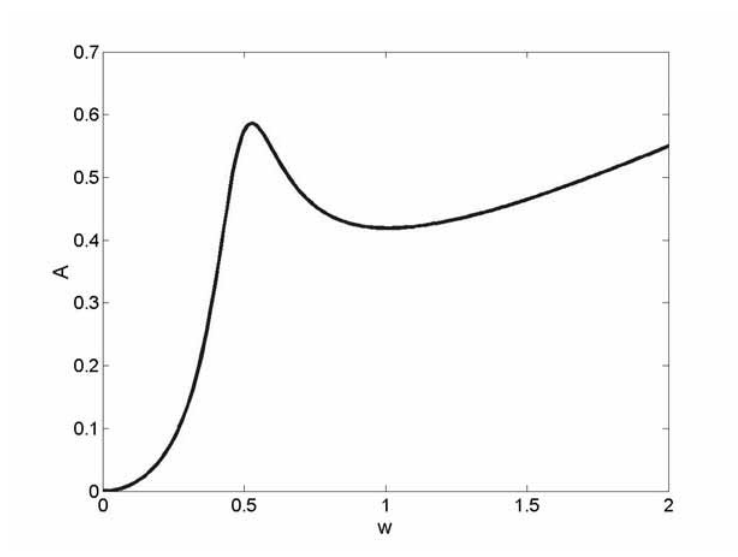
Fig. 6. Absolute acceleration of the engine